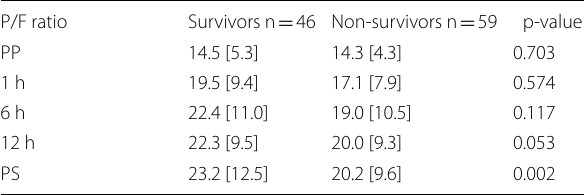
Table 1. P/F ratio of survivors and